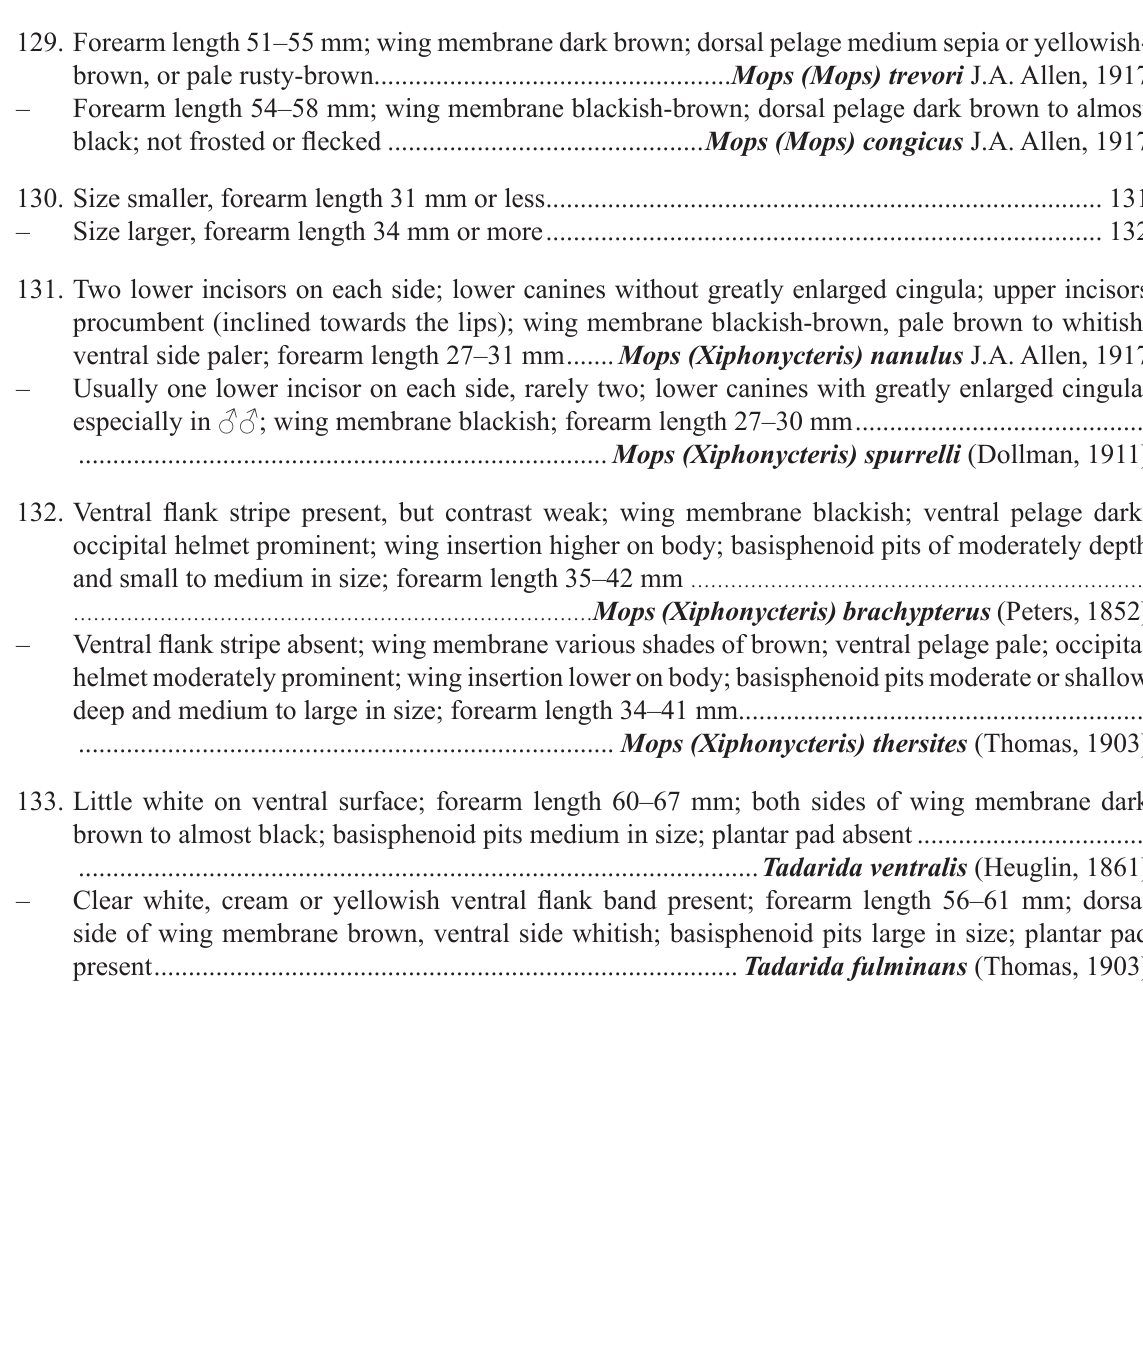
129. Forearm length 51–55 mm; wing membrane dark brown; dorsal pelage medium sepia or yellowish- – Forearm length 54–58 mm; wing membrane blackish-brown; dorsal pelage dark brown to almost black; not frosted or flecked .............................................. Mops (Mops) congicus J.A. Allen, 1917 130. Size smaller, forearm length 31 mm or less ................................................................................. 131 – Size larger, forearm length 34 mm or more ................................................................................. 132 131. Two lower incisors on each side; lower canines without greatly enlarged cingula; upper incisors procumbent (inclined towards the lips); wing membrane blackish-brown, pale brown to whitish, ventral side paler; forearm length 27–31 mm ....... Mops (Xiphonycteris) nanulus J.A. Allen, 1917 – Usually one lower incisor on each side, rarely two; lower canines with greatly enlarged cingula, especially in ♂♂; wing membrane blackish; forearm length 27–30 mm .......................................... 132. Ventral flank stripe present, but contrast weak; wing membrane blackish; ventral pelage dark; occipital helmet prominent; wing insertion higher on body; basisphenoid pits of moderately depth